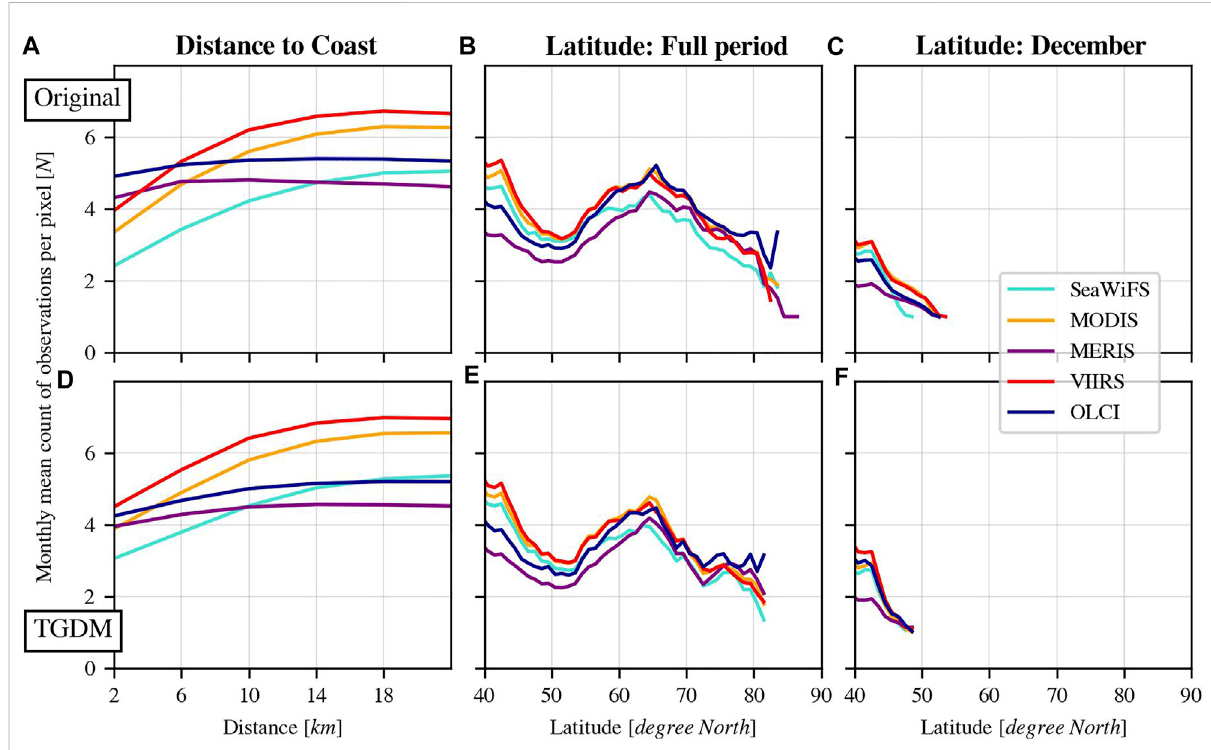
FIGURE 6 Global monthly-averaged number of observations per pixel for each satellite sensor (see legend) as a function of: the pixel centre ’ s distance to the coastline (binned on 4 km and the x -axis shows the bin centre) (A,D) , the latitude for the full period (binned on 1 ° for the northern hemisphere) (B,E) , and the latitude for only the northern winter month December (C,F) . Shown are the results for the original data set (top: (A – C) and the data set after applying the TGDM (bottom: (D – F)